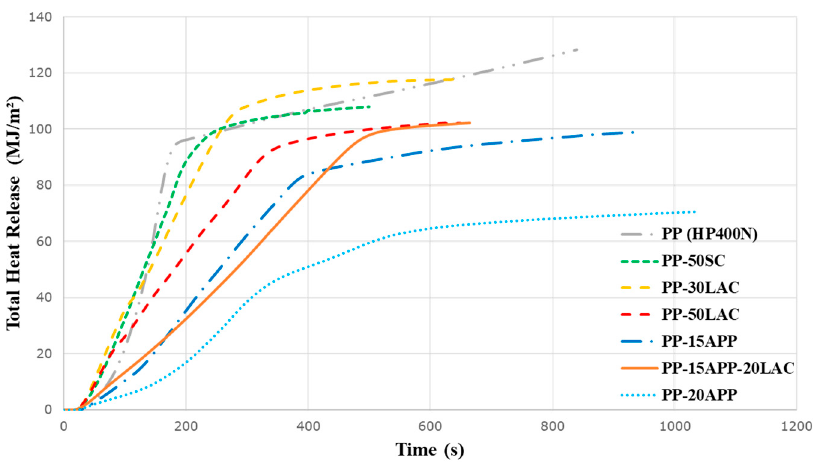
Figure 8. Total heat release (THR) curves of neat PP, PP-30%LAC, PP-50% LAC/SC, PP-15%/20% APP, and PP-15%APP-20%LAC